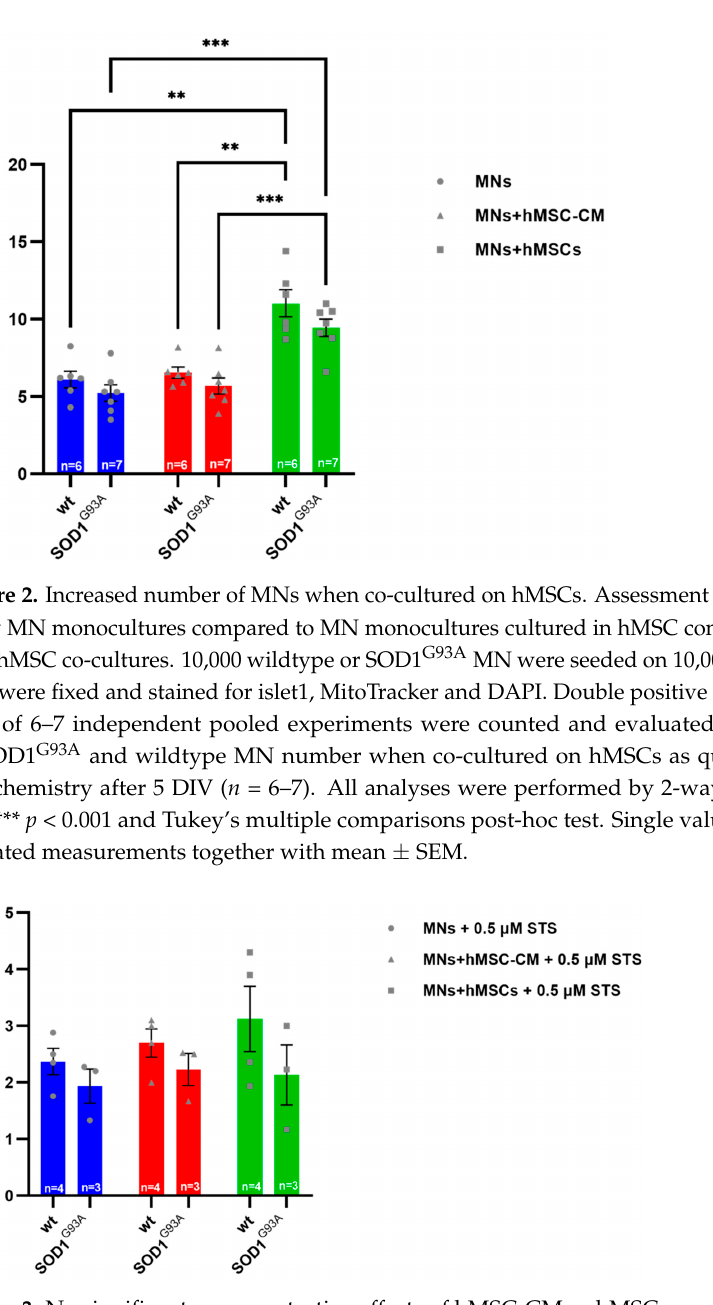
Figure 3 . No significant neuroprotective effects of hMSC-CM or hMSC co-culture on STS-exposed wildtype and mutant SOD1 G93A MNs. Assessment of MN numbers in MN-hMSC-CM and primary MN-hMSC co-cultures. 10,000 wildtype or SOD1 G93A MNs were seeded on 10,000 hMSCs. After 5 DIV cells were exposed to a STS concentration of 0.5 µM for 24 h. After STS exposure, on day 7, medium was removed and cells were fixed and stained for islet1, MitoTracker and DAPI. Double positive (islet1 + /MitoTracker + ) cells of 3 independent pooled experiments were counted and evalu- ated. No change in wildtype or SOD1 G93A MN number when cultured in hMSC-CM or co-cultured on hMSCs after 0.5 µM STS exposure as quantified by immunocytochemistry after 7 DIV ( n = 3). All analyses were performed by 2-way ANOVA and Tukey’s multiple comparisons post-hoc test. Single values are represented as repeated measurements together with mean ± SEM.